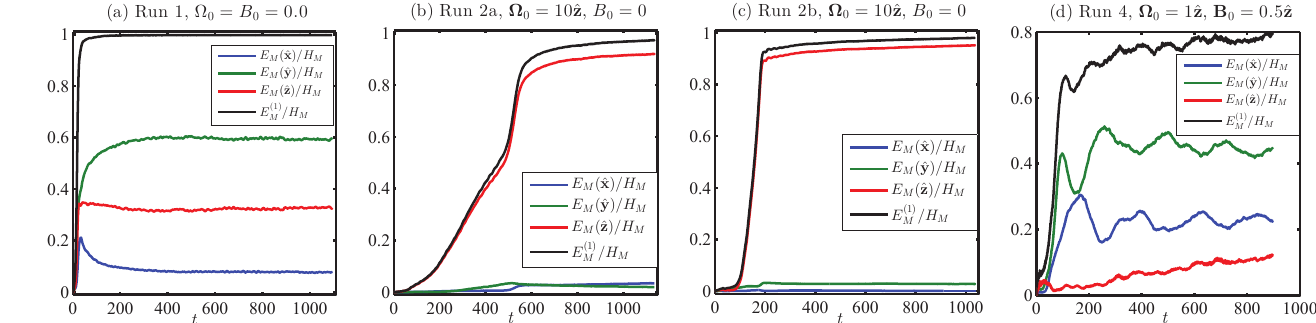
H M with time. (In ( d ), M →